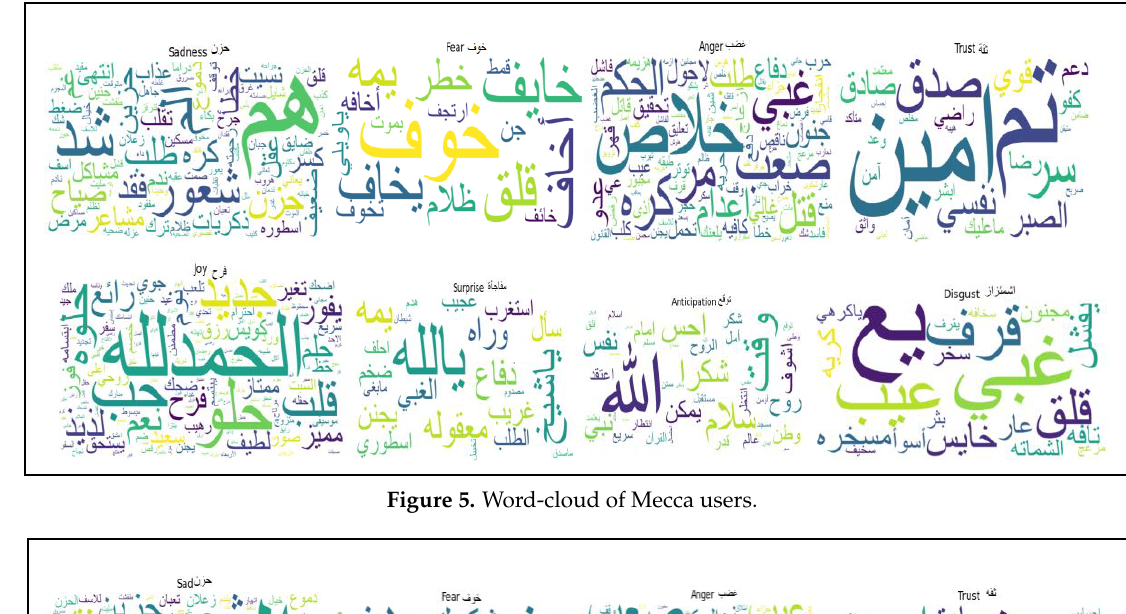
Figure 5. Word-cloud of Mecca users.